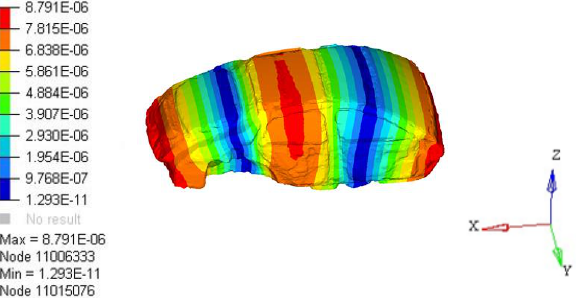
Figure 14. Model vibration shape of the second-order acoustic cavity.